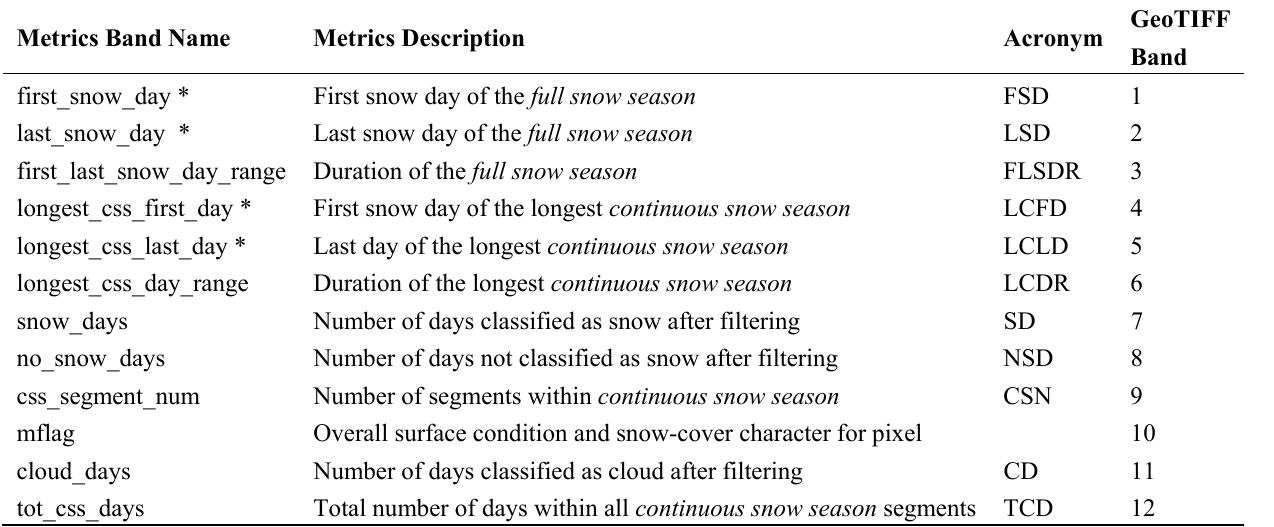
Table 1. Snow metrics, definitions, and band